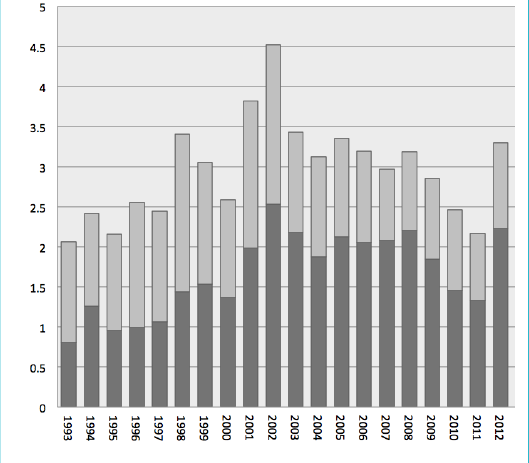
Figure 1: Incidence of MSSA bloodstream infection per 10 000 pa- tient-days from 1993 to 2013.CA = community acquired; MSSA = methicillin-sensitive Staphylococcus aureus ; NO = nosocomial